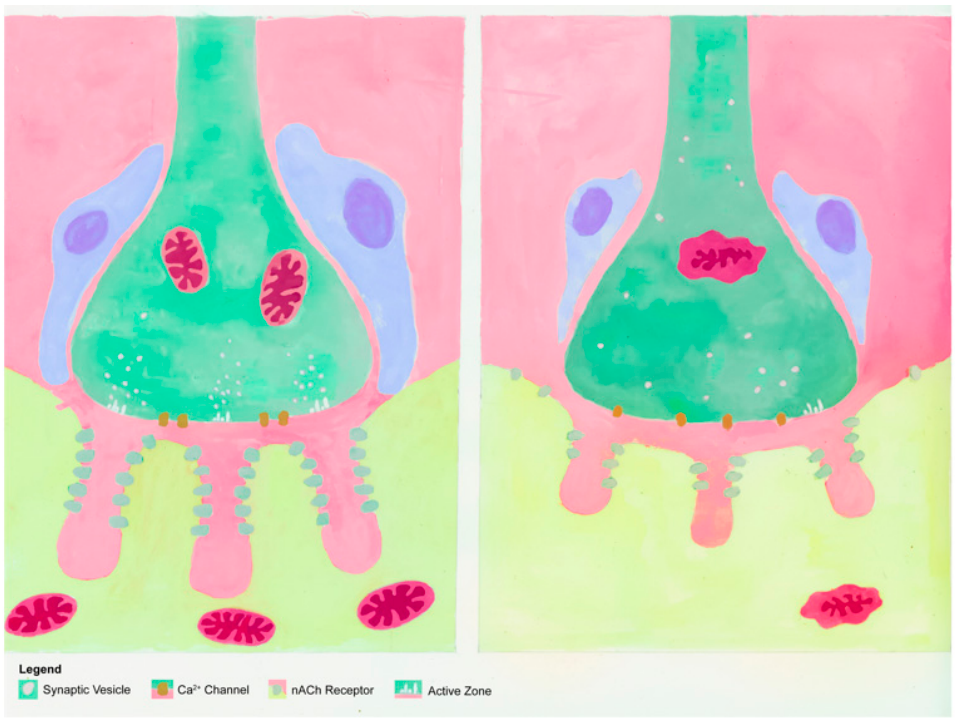
Figure 4. Illustration of aged and young adult endplates. Note more shallow gutters in the aged neuromuscular junction, with fewer receptors. As a further sign of the gradual denervation that occurs with aging, thus leading to NMJ remodeling, it has been reported that aged myofibers express greater amounts of the neural cell adhesion molecule (NCAM) than younger fibers (Figure 5). This supports the notion that remodeling of the NMJ is a lifelong process that is enhanced, but not initiated, by aging. The NCAM is a synaptogenic molecule expressed by denervated tissue as it has chemotactic effects that draw nerve-terminal endings to sites where the NCAM is ex- pressed [76–78].